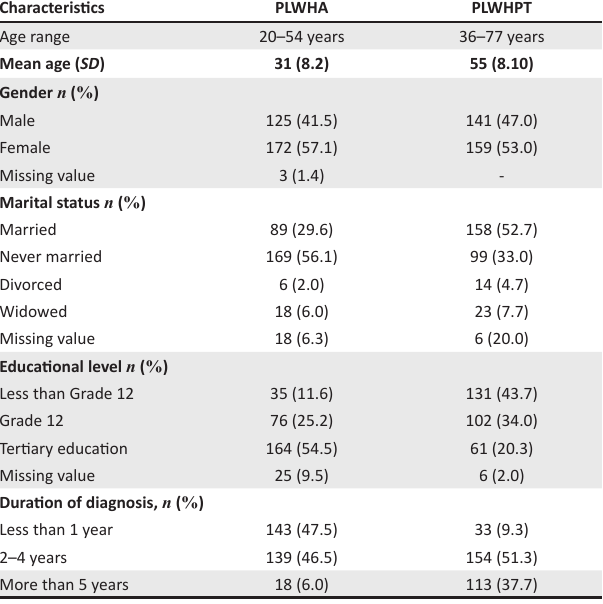
TABLE 1: Demographic characteristics of participants ( n = 300). Characteristics